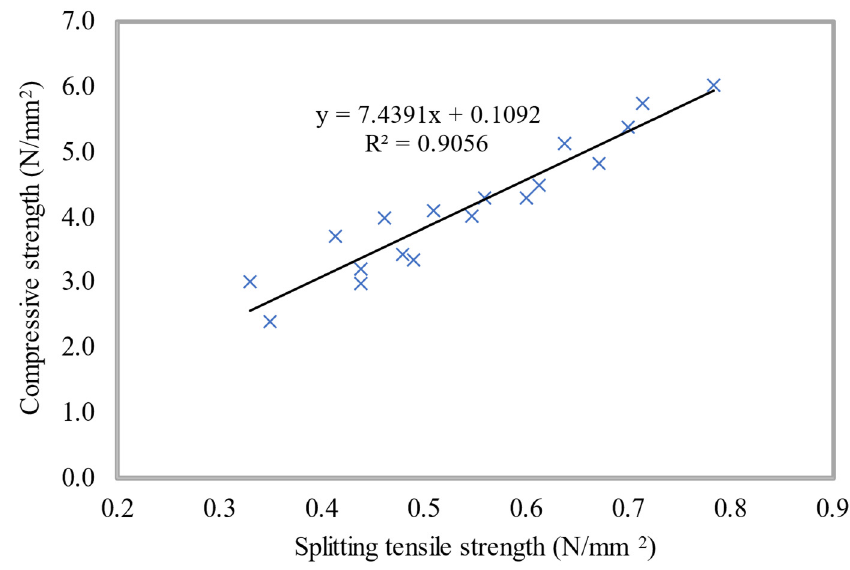
Figure 26. Relationship between the compressive and tensile strengths for 900 kg/m 3